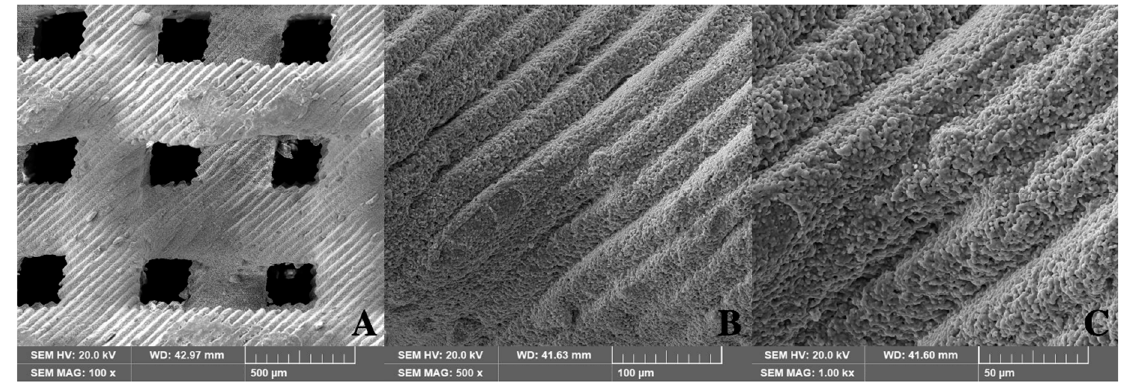
Figure 4. Structure of 3D-printed HA/TCP scaffolds (SEM, 0.8 mm pore): ( A ) 100×, ( B ) 500×, and ( C ) 1000×.